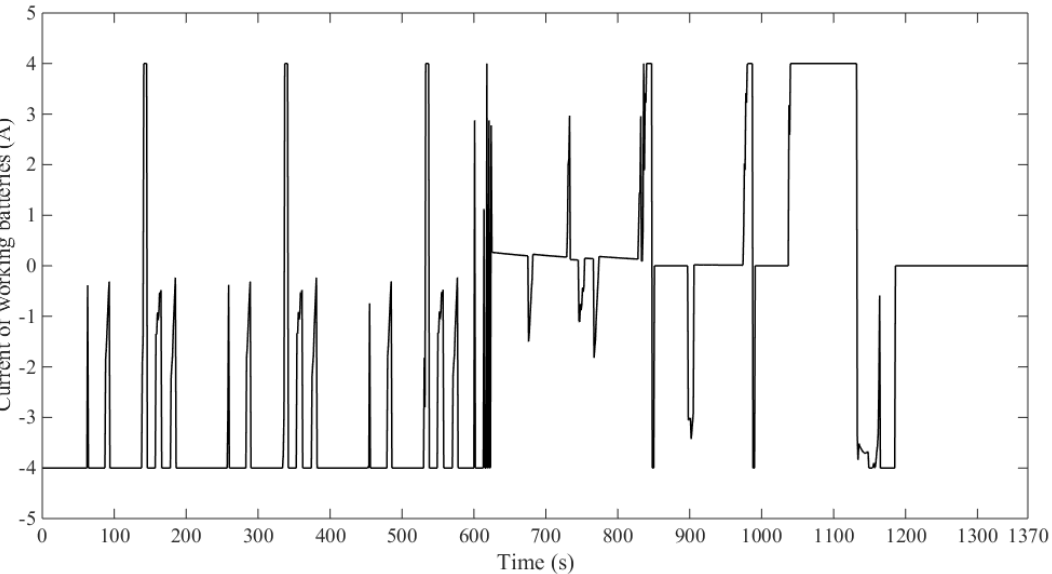
Figure 12. The current of working batteries.